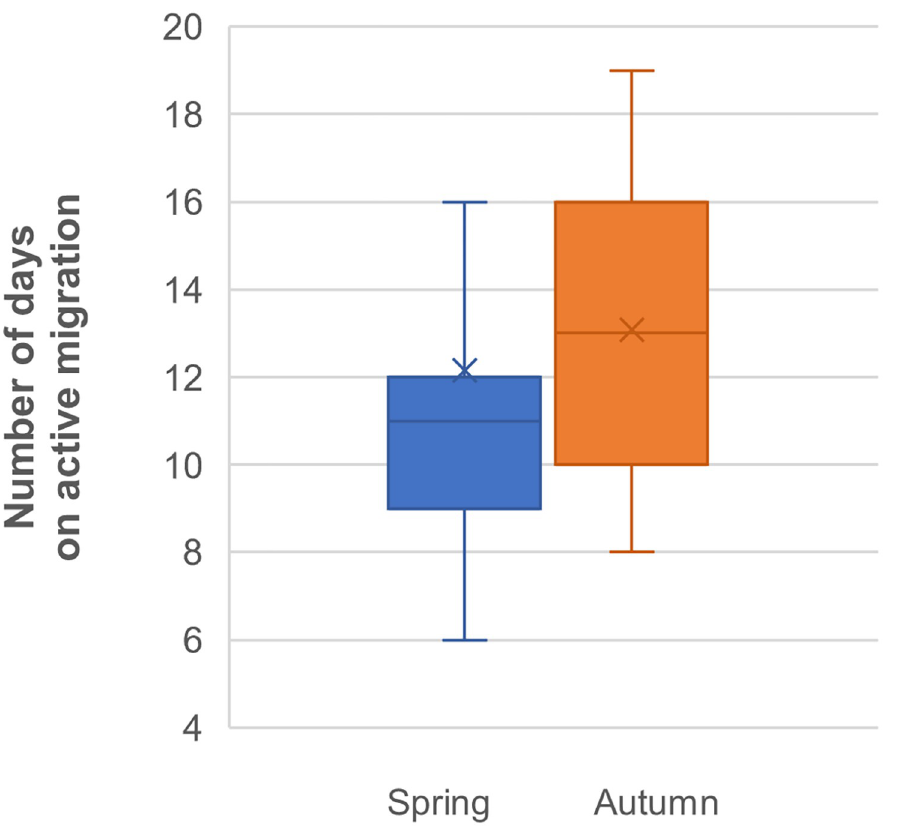
Fig 4. Days of active migration in spring (blue) and autumn (ochre) for 13 Vega gulls. Boxes hold 50% of the values, with the median shown as a horizontal line and the mean as an ‘x’. Whiskers extend to the highest and lowest values excluding outliers.